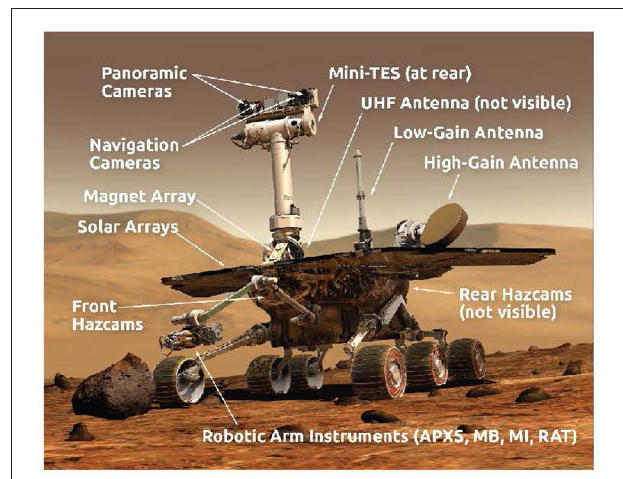
FIGURE 1 | MER rover and tools. Image credit: